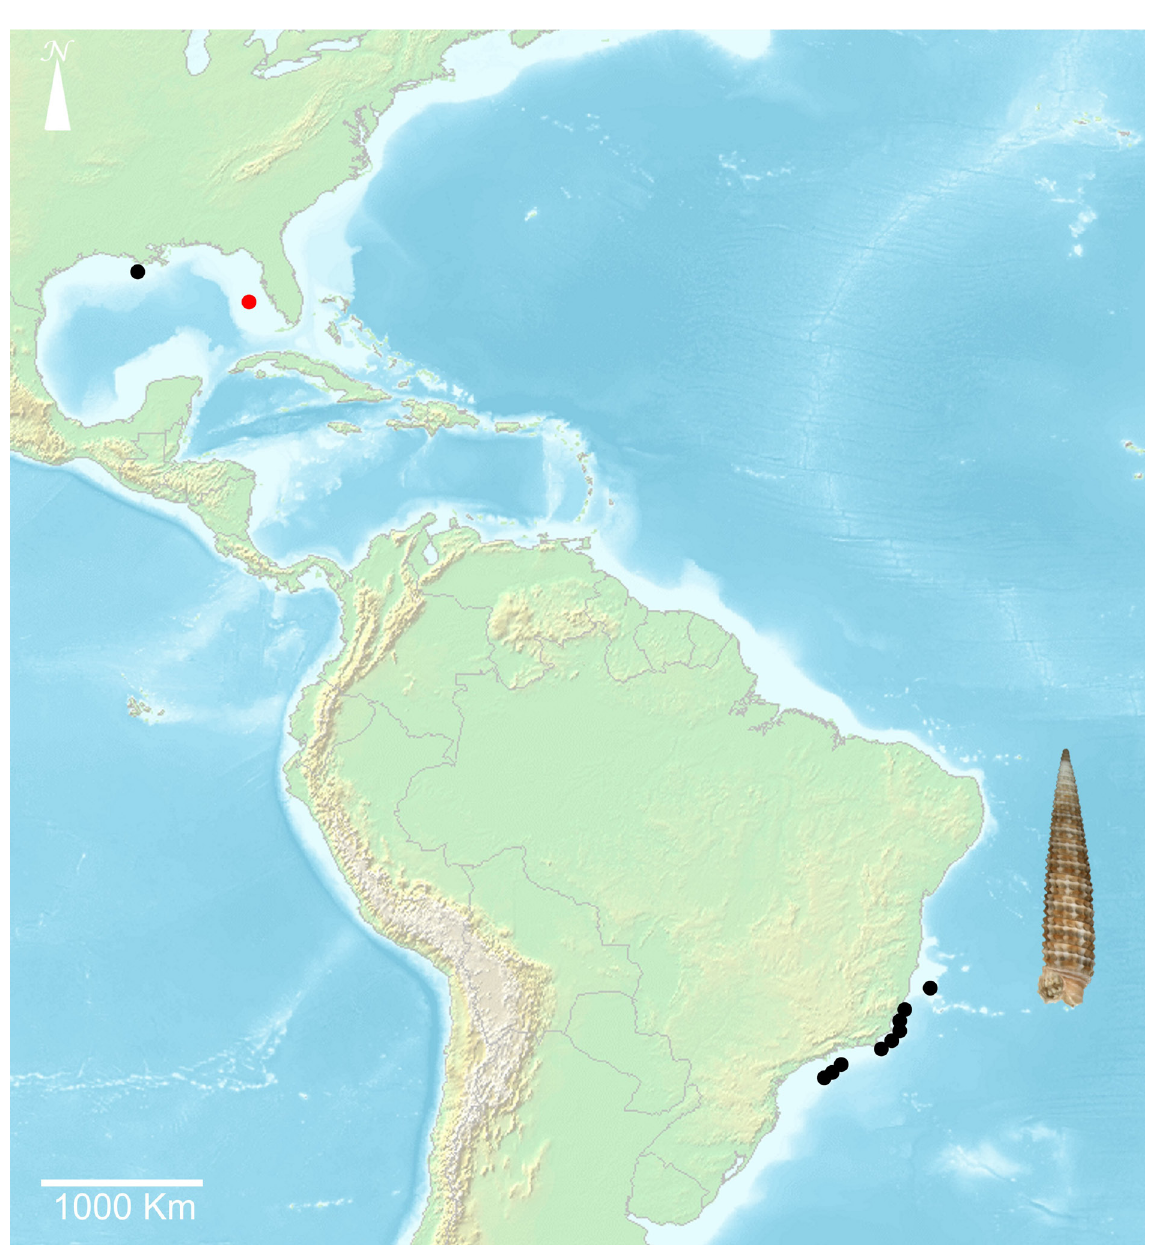
Fig. 71. Distribution map of Strobiligera inaudita (Rolán & Lee, 2008); red circle = type